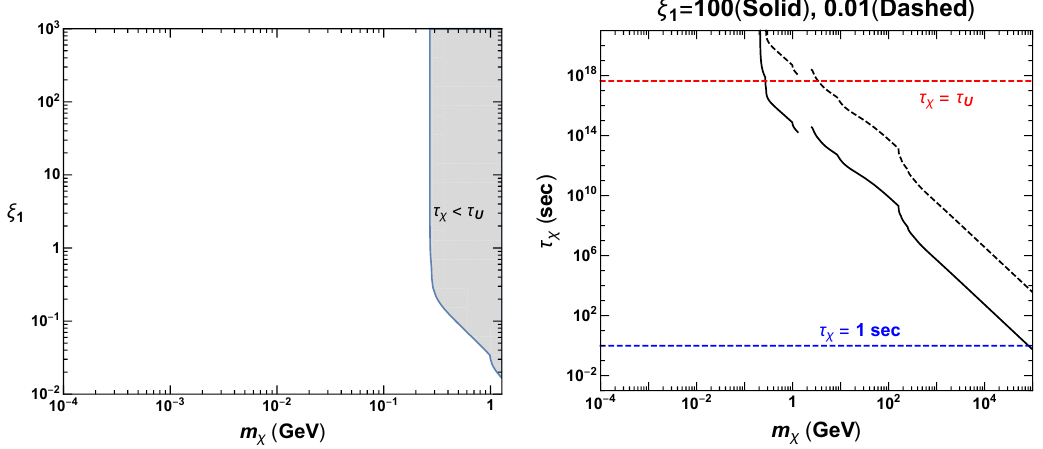
Figure 6 . Left: parameter space for long-lived in(cid:13)aton in the plane of m (cid:31) and (cid:24) 1 . The lifetime of the sigma (cid:12)eld in(cid:13)aton is shorter than the age of the Universe in gray region. Right: lifetime of the in(cid:13)aton as a function of m (cid:31) for (cid:24) 1 = 100 ; 0 : 01 in black solid and dashed lines, respectively. Red and blue dashed lines correspond to (cid:28) (cid:31) = (cid:28) U and 1 sec. into an electron pair below the muon threshold but above the electron threshold. On the other hand, in the case of heavy in(cid:13)aton, the in(cid:13)aton decays dominantly into gluons or fermion pairs below the W W threshold, while it decays dominantly into the electroweak sector, hh; ZZ; W W , above the W W